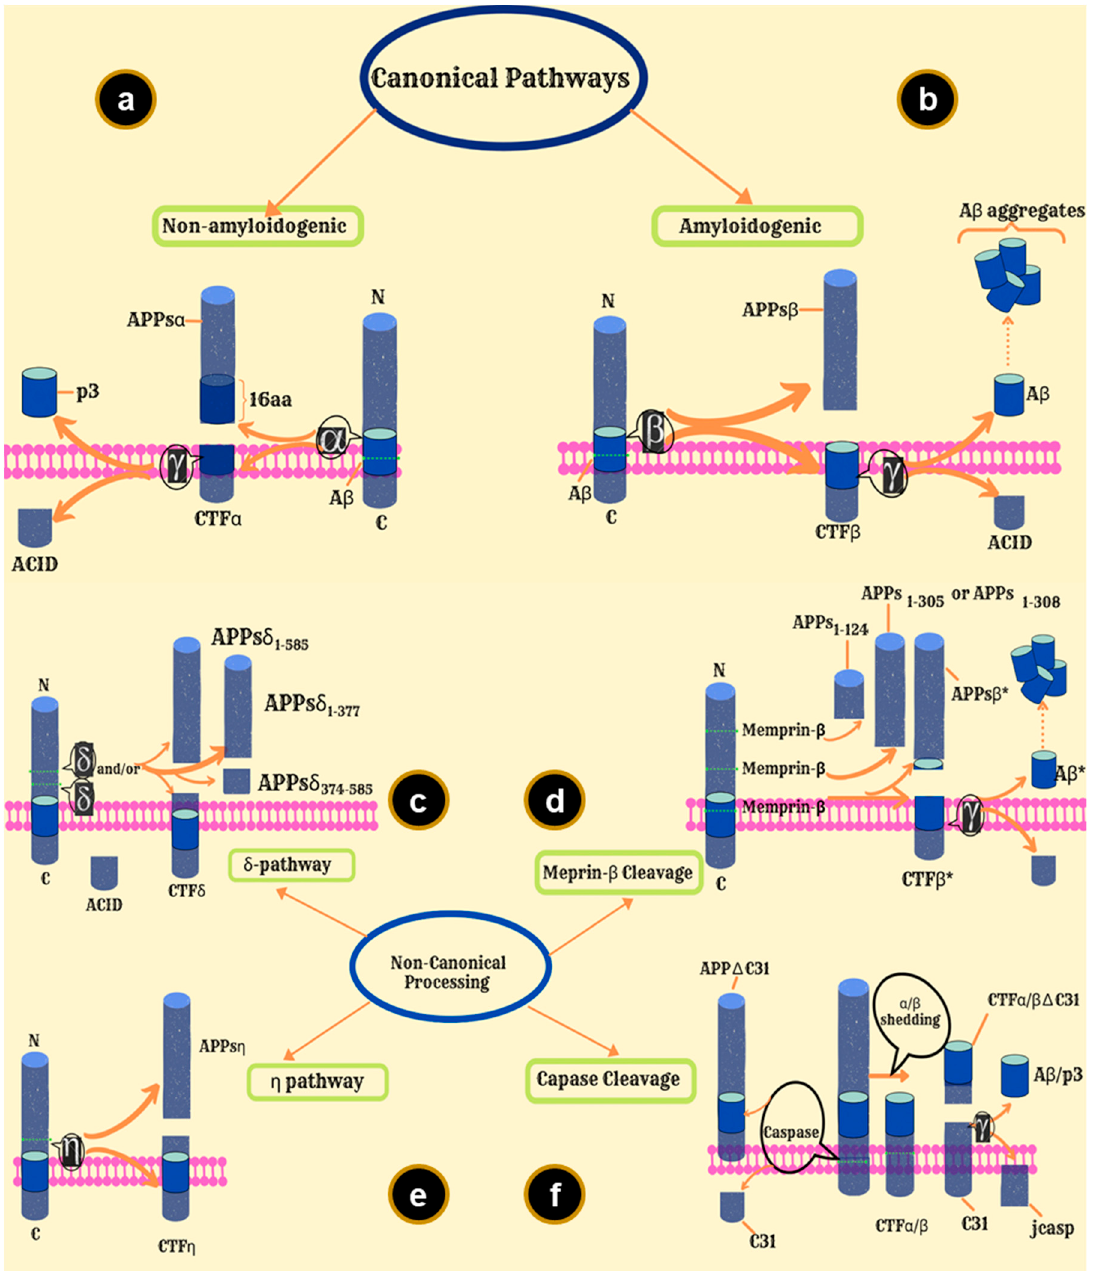
Figure 4. The canonical amyloid precursor protein (APP) processing pathways: ( a ) processing by α -secretase along the non-amyloidogenic pathway occurs in the amyloid- β (A β ) region, liberates APPs α ( α -secretase-generated APP ectodomain fragment) and generates p3; ( b ) processing along the amyloidogenic pathway generates A β (through β -secretase and γ -secretase cleavage) and liberates APPs β . The schematic shows the non-canonical APP processing; ( c ) cleavage by δ -secretase produces three soluble APPs δ fragments and C-terminal fragment- δ (CTF δ ), which are further processed by β -secretase and γ -secretase; ( d ) cleavage by meprin- β at three sites gives rise to three soluble fragments (top right panel). APPs β * contains one additional residue compared with APPs β ; ( e ) cleavage by η -secretase gives rise to soluble APPs η and CTF η , which is further processed by α -secretase or β -secretase to generate A η - α or A η - β ; ( f ) caspases cleave within the intracellular domain to yield C31 and after subsequent γ -secretase cleavage.